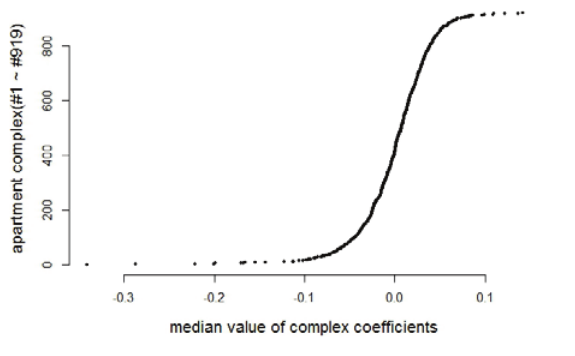
Figure 9. Distribution of complex coefficients The complexes are sorted by their median coefficients. The range of the complex coefficients goes roughly from –0.3 to 0.1, which leads to a great difference in the ultimate ratio of an apartment unit.